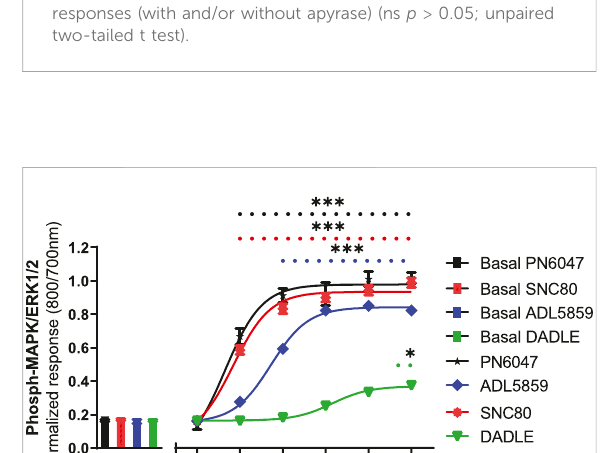
FIGURE 7 Effect of DOPr agonists: SNC80, ADL8859, DADLE, and PN6047, on ERK phosphorylation in CHO-K1-hDOPr cells. Cells were cultured in growth medium for 24 h, followed by serum starvation for 24 h. Cells were stimulated with various concentrations of DOPr agonists for 5 min, followed by rapid fi xation with PFA solution (4% w/v). Detection of total and phospho-ERK levels was carried out as stated in the Methods section. The bars show basal ERK responses from unstimulated cells. The data shown represent the mean ± SEM of four experimental repeats, each run-in triplicate. Statistical signi fi cance was determined using an unpaired two-tailed t-test; * p <